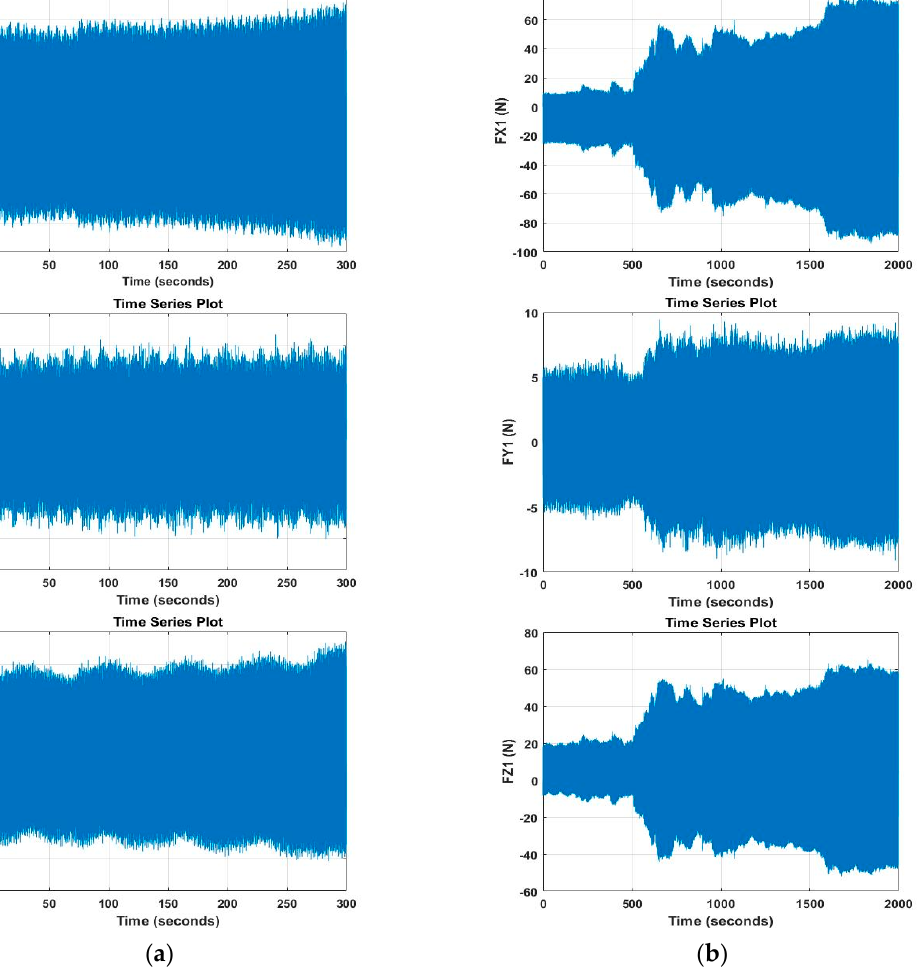
Figure 11. Force transmission results for projection unit from GUI: ( a ) results for case I; ( b ) results for case II.